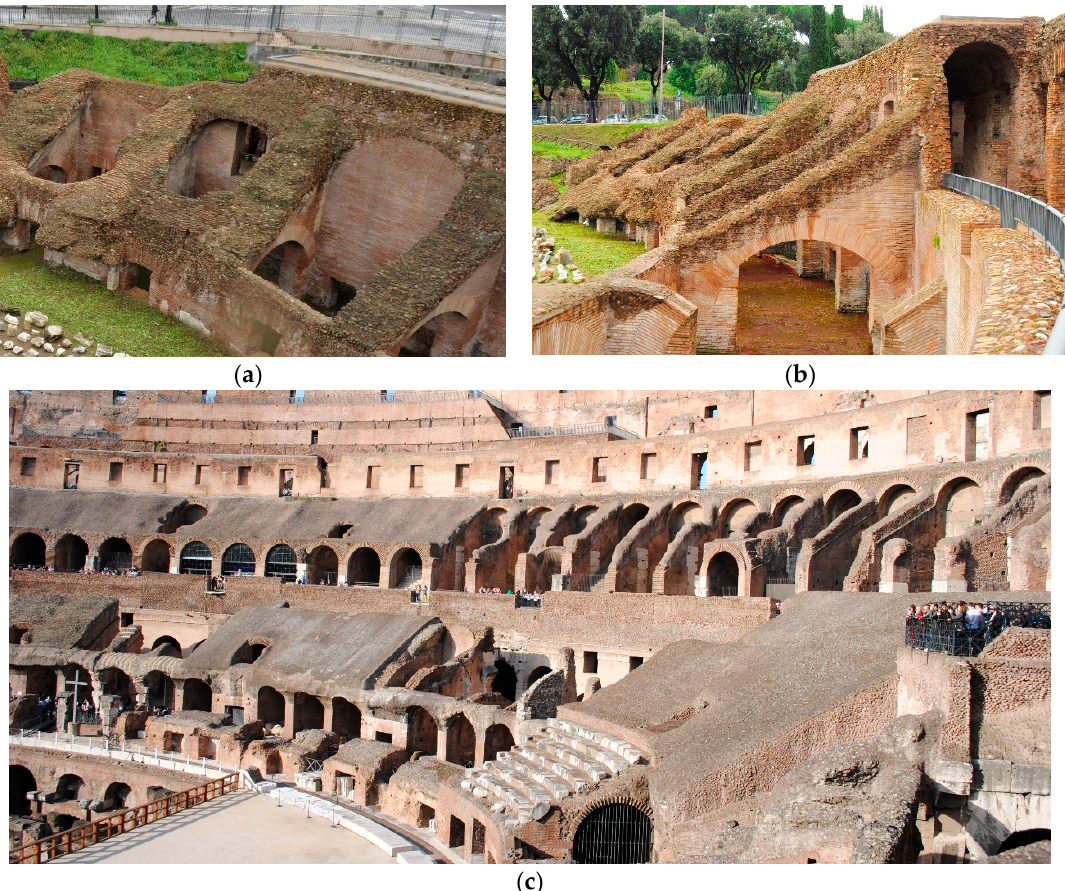
Figure 7. Examples of the structure built as a support of the podium with a double purpose, upholding the structure of the seats and corridor for the public to reach their seats: ( a , b ) Circus Maximus in Rome; ( c ) Flavius Amphitheatre (Colosseum) in Rome.